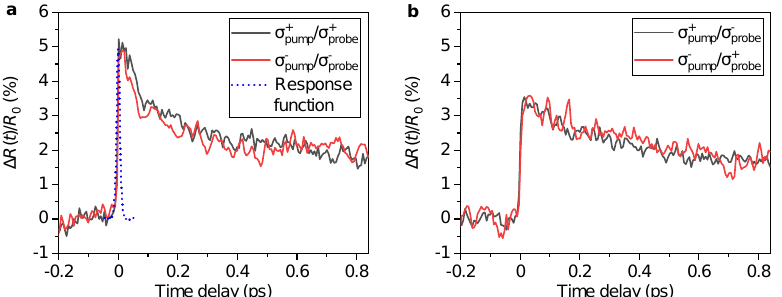
Figure A2. ( a ) Change of transient reflectivity of the sample integrated form the regions of spectra of interest for co-rotating circular polarizations of the pulses σ + pump / σ + dotted curve shows the measurement response function obtained as cross-correlation of pump and probe pulses in a thin BBO crystal. ( b ) Change of transient reflectivity of the sample integrated from the regions of spectra of interest for counter-rotating circular polarizations of the pulses σ + pump / σ − . All curves are measured with the pump fluence of 42.88 µ J/cm 2 . and σ − pump / σ + probe